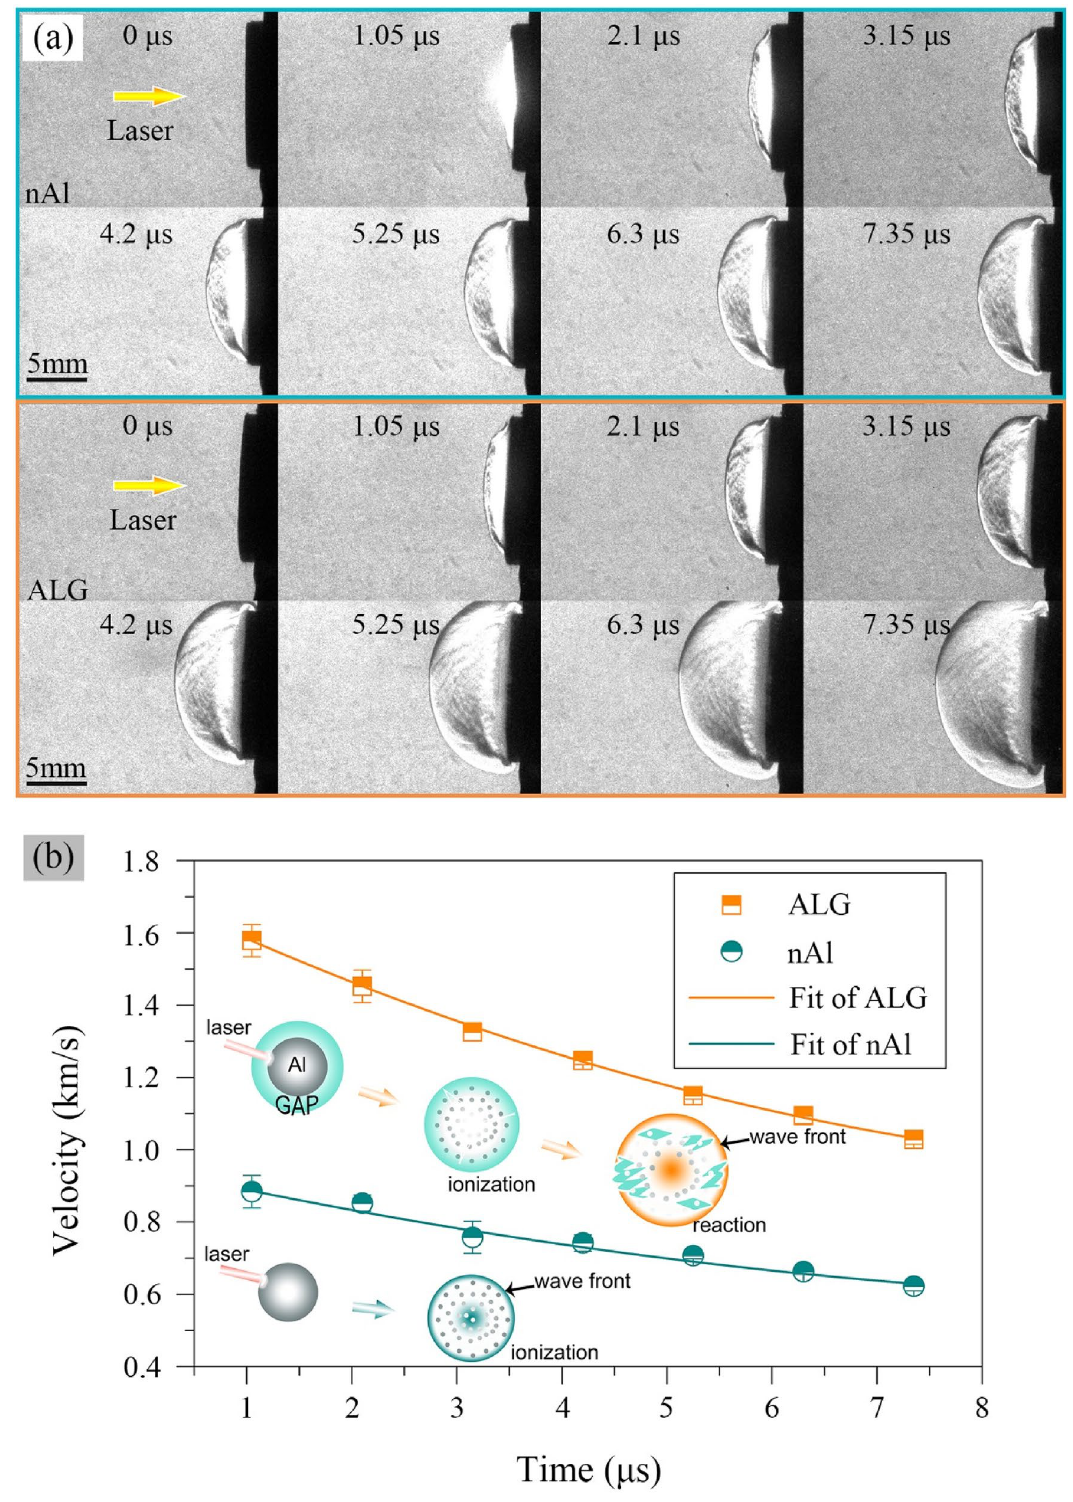
Figure 8. Schlieren images shock wave generated by nAl and ALG under laser stimulus ( a ) and wave front velocity (y-intercept of a 2nd order polynomial fit) ( b